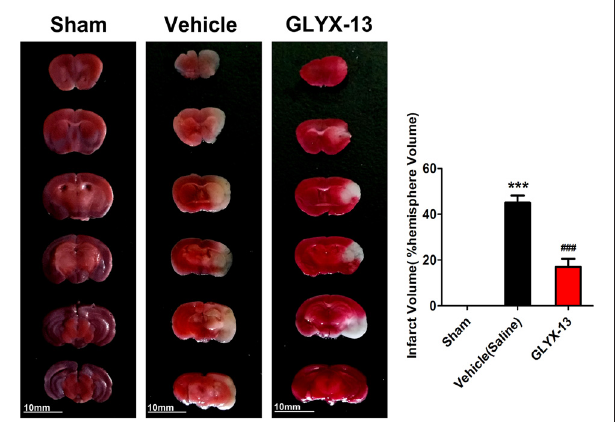
FIGURE 2 | GLYX-13 treatment reduced ischemic infarct volume in vivo middle cerebral artery occlusion (MCAO) model. Cerebral infarct volume was assessed via triphenyltetrazolium chloride (TTC) staining of coronal sections 24 h after reperfusion in representative mice. The infarct volume was analyzed in each group. Data were expressed as mean ± SEM ( n = 12 animals per group). One-way analysis of variance (ANOVA) and Newman-Keuls post test, ∗∗∗ p < 0.001, vs. Sham; ### p < 0.001, vs. vehicle.